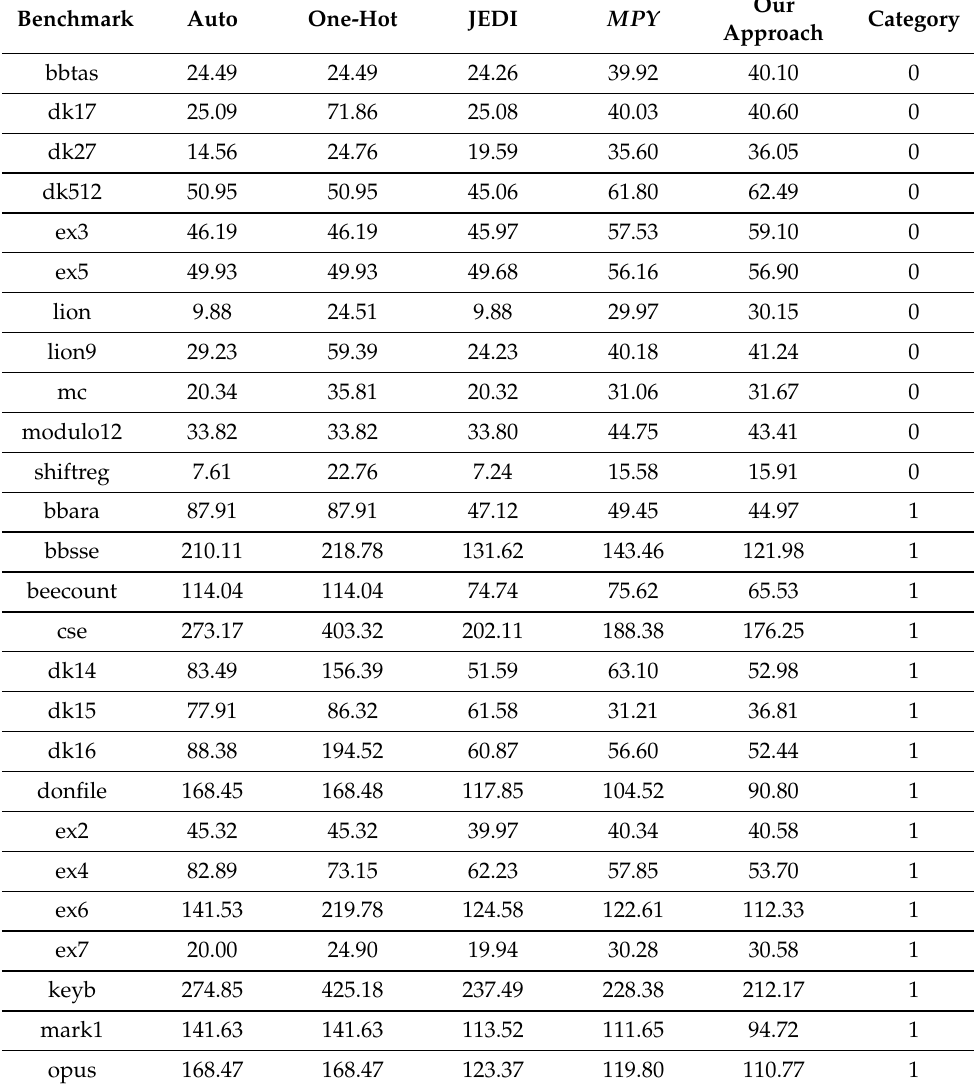
Table 11. Experimental results (area-time